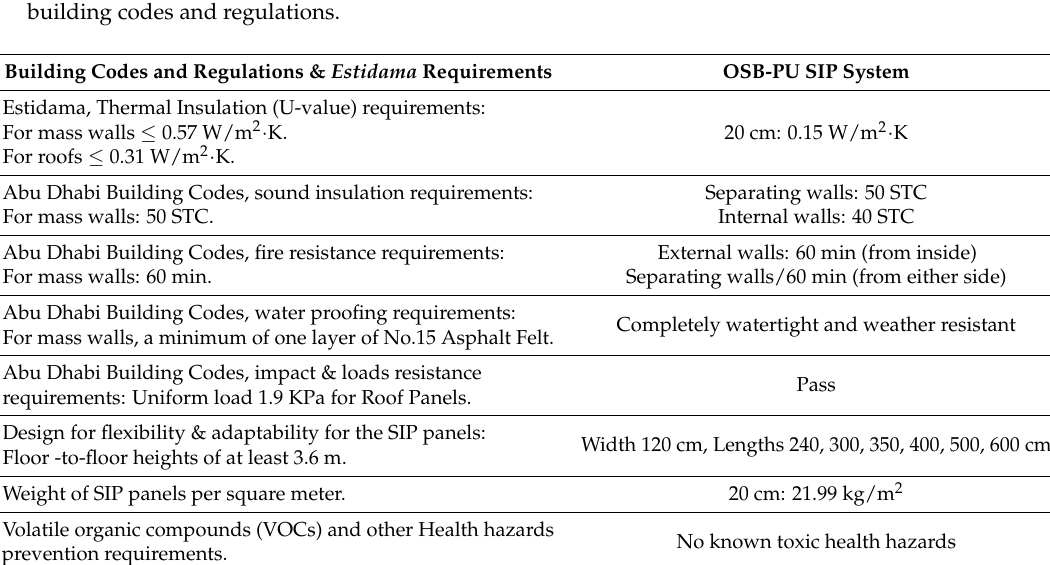
Figure 3. Installation of the OSB-PU SIPs (Source: By Scott Blake https://unsplash.com/photos/ 3tjM7Un88IA). Table 3. Compliance of the OSB-PU SIP System with Estidama sustainability requirements and local building codes and